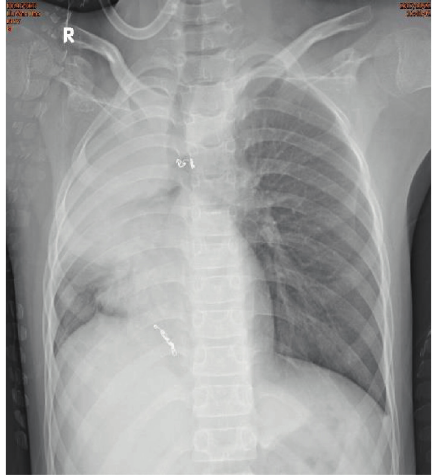
Figure 6: Chest X-ray documented atelectasis in the right